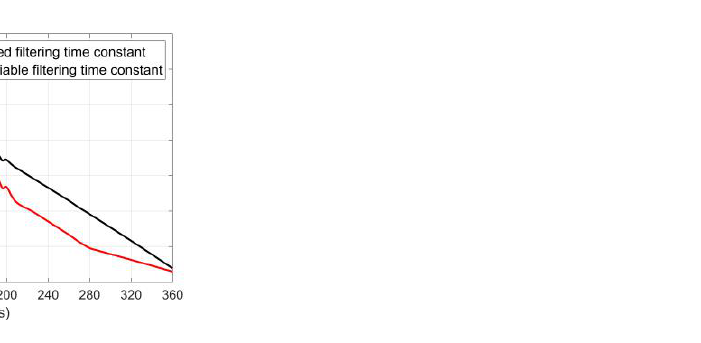
Figure 22. FC reference current curve.